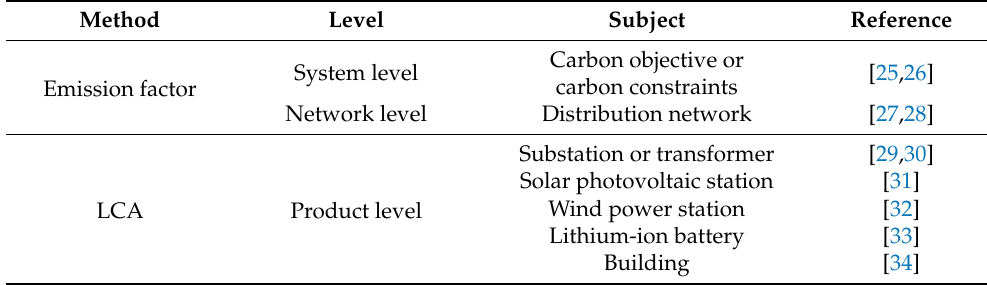
Table 1. Literature of carbon emission analysis for